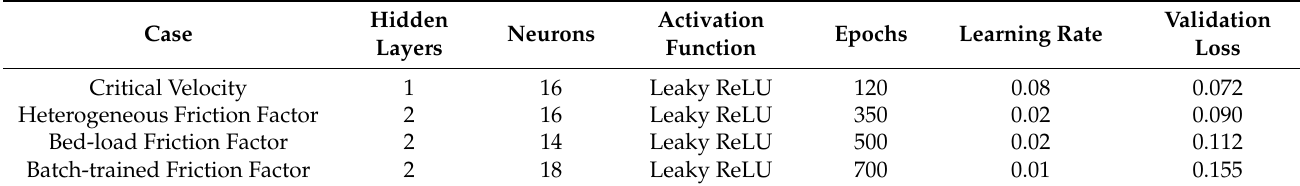
Table 5. Optimum hyper-parameters obtained by the ANN algorithm.